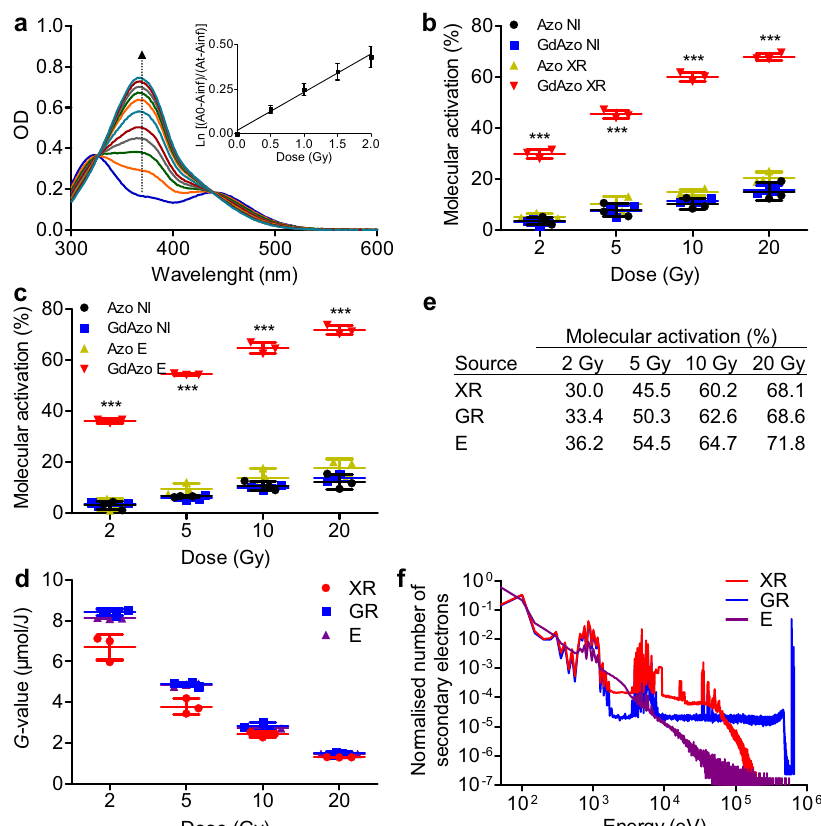
Fig. 3 Characterisation of cis -GdAzo activation upon different radiation sources. a Absorbance spectra of cis - GdAzo (PSS1 in blue) recorded after GR (0.5 Gy increment in the 0.5-2 Gy range and 1 Gy increment in the 2-8Gy range). The graph Ln[(A0-Ainf)/(At-Ainf)] by the irradiation dose (0.5-2Gy range) is plotted on the top-right corner, with A0, Ainf and At the absorbances of PSS1, trans - GdAzo and the mixture at a speci fi c irradiation dose respectively. Linear regression (least-squares method, r 2 : 0.9521, GraphPad Prism 5.00) were used to determine the activation constant k = (2.1 ±0.2) *10 − 1 Gy − 1 (triplicate, n = 3 independent experiments, F -value = 258.3, P < 0.0001). b , c Molecular activation of cis - GdAzo and cis - Azo determined by HPLC and reported as the difference of trans -isomer proportion before and after XR ( b ) and E ( c ) irradiations (n = 3 independent experiments). Two-way Anova (Bonferroni post-test) was used for statistical analyses (All vs GdAzo GR, t -values = 16.93, 23.90, 30.65, 33.01 and 19.04, 28.43, 32.09, 34.01 for GdAzo NI vs GdAzo GR at doses 2, 5, 10, and 20Gy upon XR and E respectively). *** P < 0.001. d Radiochemical yields ( G -values) of trans - GdAzo determined by HPLC (corrected from thermal back relaxation) upon XR, GR and E irradiations ( n = 3 independent experiments). e Molecular activation of cis - GdAzo upon XR, GR and E irradiations determined by HPLC. f Monte Carlo simulation to quantify the energy of secondary electrons emitted by the interaction of the incident primary particle on the Gd atom upon XR, GR and E irradiations. The means ± standard deviations are reported. OD optical